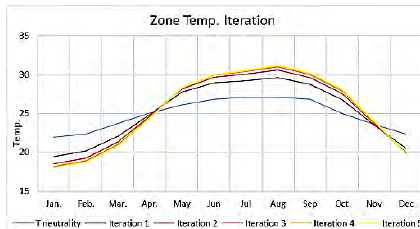
Figure 10. Cross-section of the calibrated basement floor and slab layers.